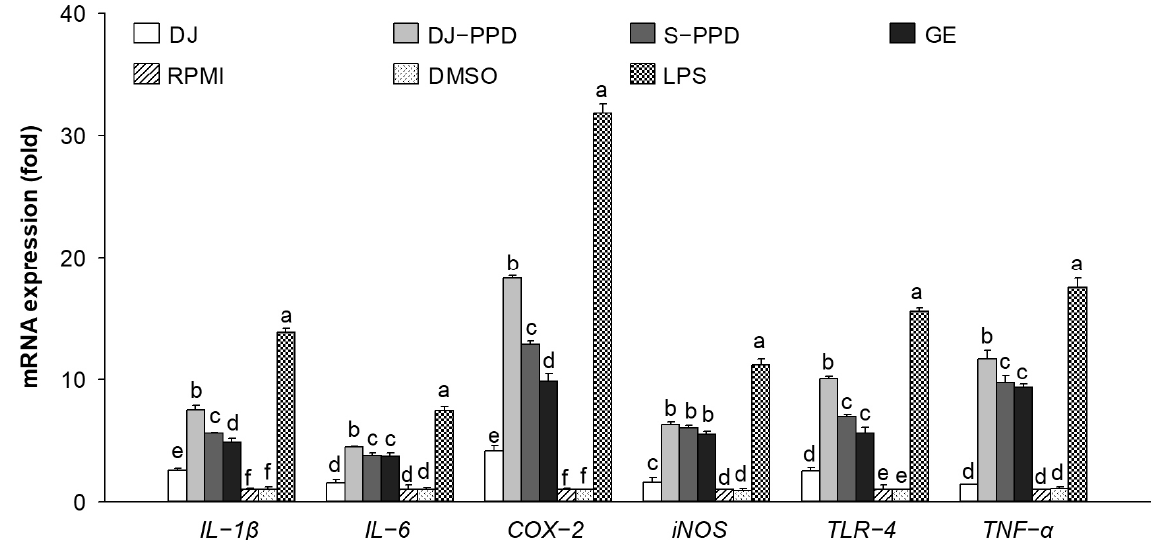
Figure 4. Inflammation-related mRNA upregulation in cells pretreated with DJ extract, DJ-PPD extract, S-PPD, and GE extract. Cells were collected for RNA extraction after 6 h of incubation. DJ, DJ-PPD, and GE concentrations were 100 µg/mL, whereas the S-PPD concentration was 700 pg/mL. DMSO and LPS concentrations were 0.1% and 1 µg/mL, respectively. Data are shown as means ± standard deviations. Different lowercase letters indicate significant differences among treatments at p < 0.05.